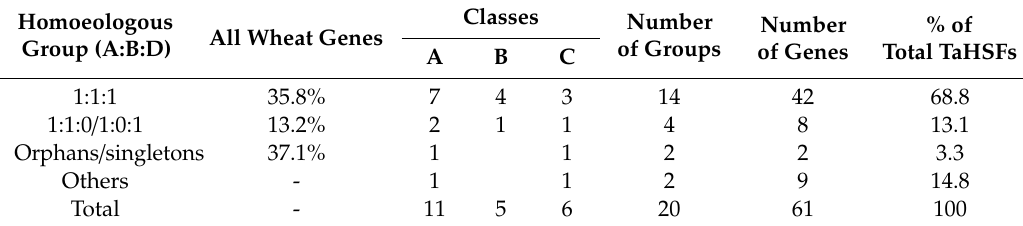
Table 1. Homeologous groups in wheat HSF gene